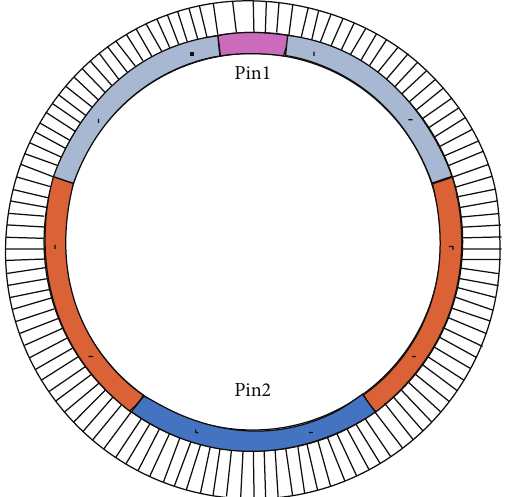
Figure 1: Grouting pressure acting on the